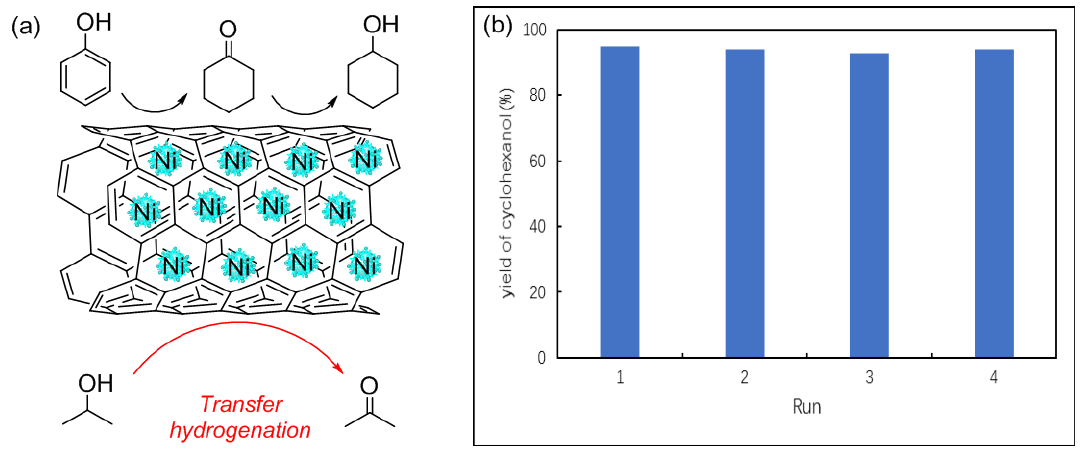
Figure 6. Catalytic pathway in the transfer hydrogenation of phenol.